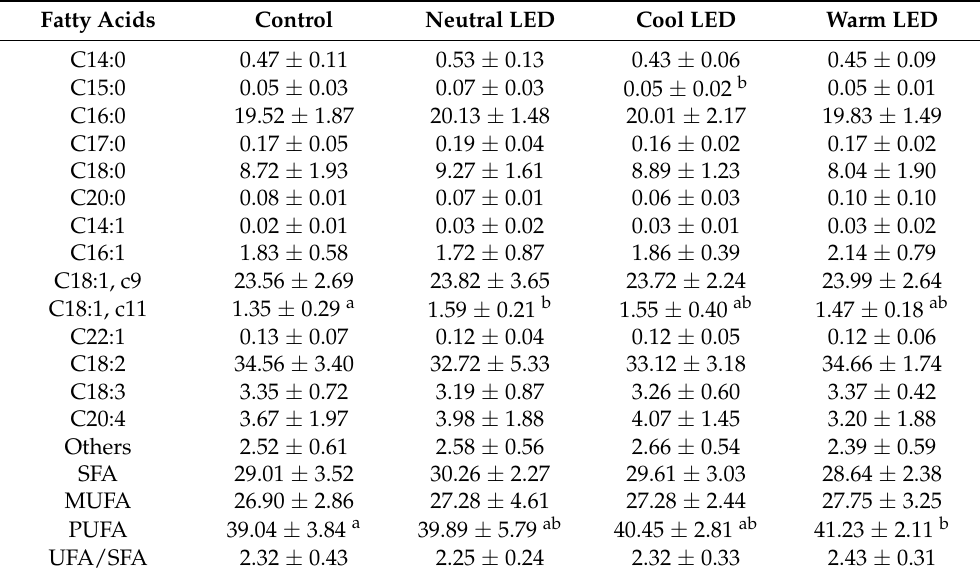
Table 3. Fatty acid profiles of breast meat samples obtained from broilers exposed to different light treatments.